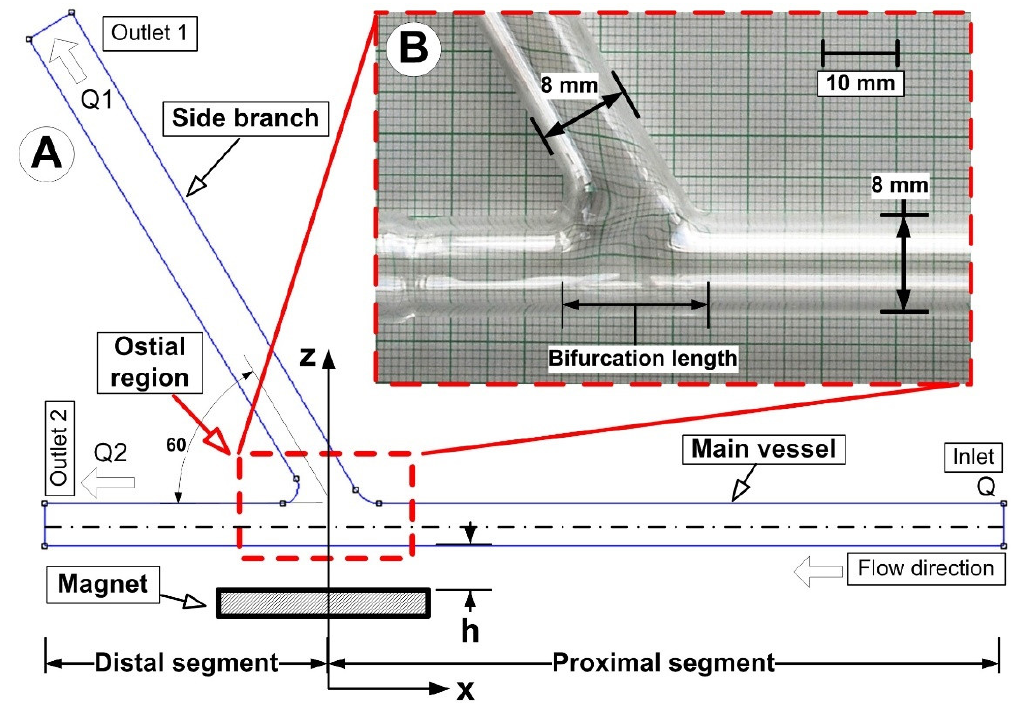
Figure 5. The investigated artery bifurcation model: ( A ) numerical model; ( B ) experimental model. The constant internal diameter of 8 mm was used for numerical and experimental model generation (both, for the main vessel and the branch).